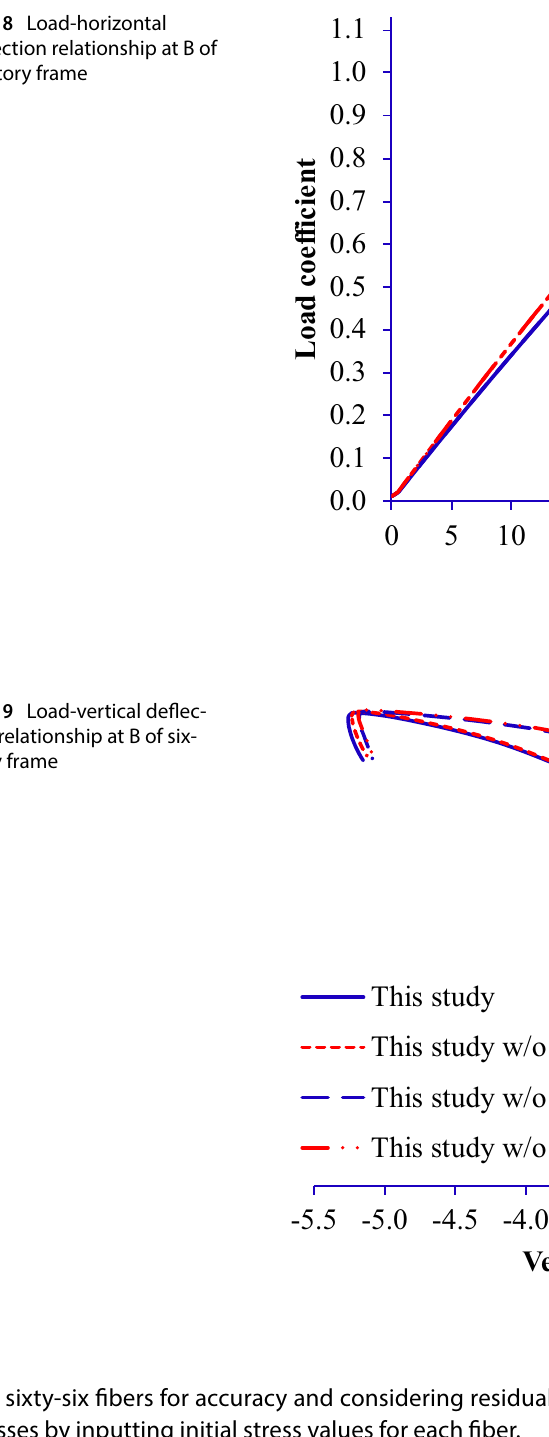
Fig. 18 Load-horizontal deflection relationship at B of six-story frame